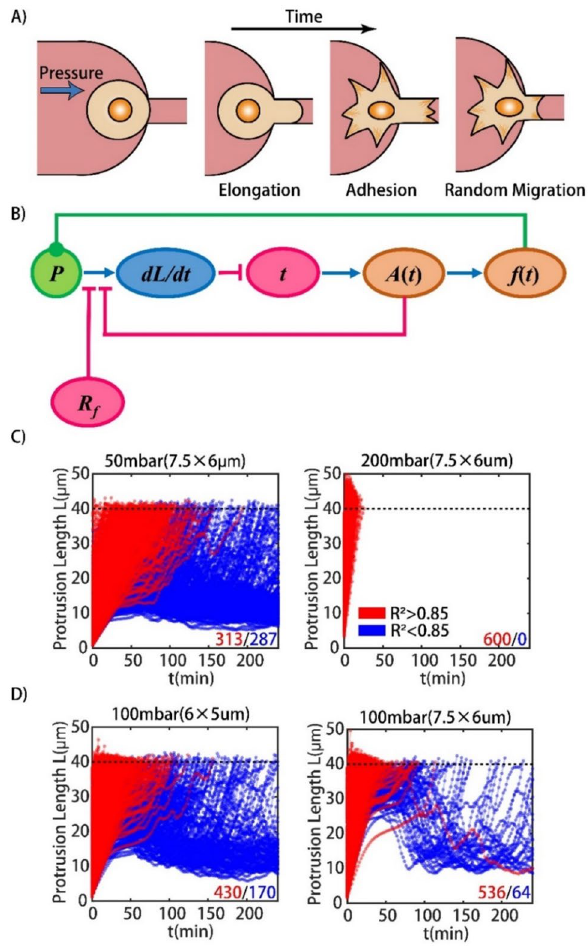
Figure 3. The model and the simulation of traverse-vessel behaviors. ( A ) Sketch map of cell elongate, and adhere/migration in the microvessel. ( B ) The model for the dynamic behavior of cells in the microvessel. ( C ) The simulation of dynamic behaviors for cells under different pressure differences (50 mbar and 200 mbar) using the microfluidic chips with the same size of microvessels (7.5 μm × 6 μm). ( D ) The simulation of dynamic behaviors for cells under the same pressure difference (100 mbar) using the microfluidic chips with different sizes of microvessels (6 μm × 5 μm and 7.5 μm × 6